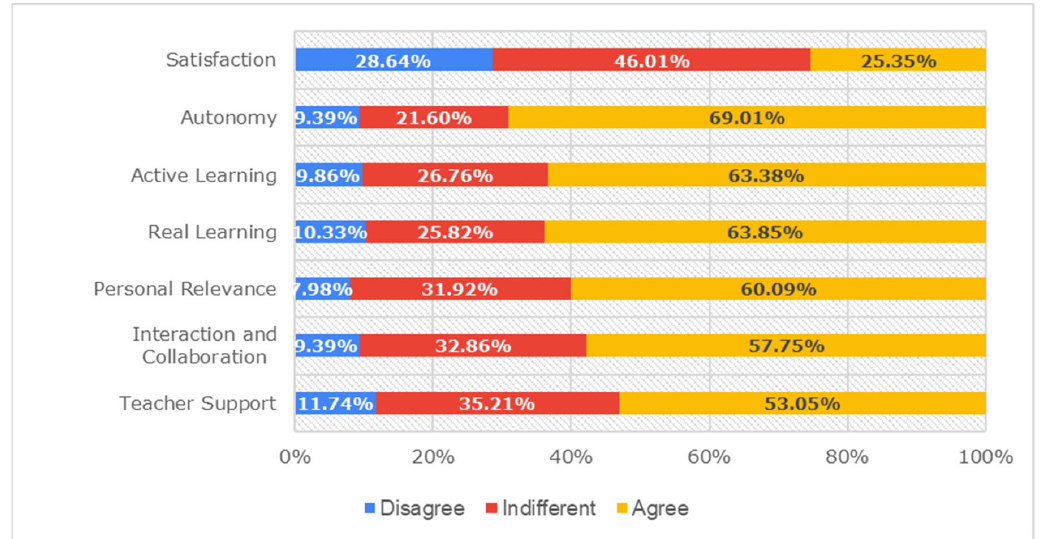
Fig. 1. Percentages of the levels of agreement (concordance) by factors in the use of the virtual classroom